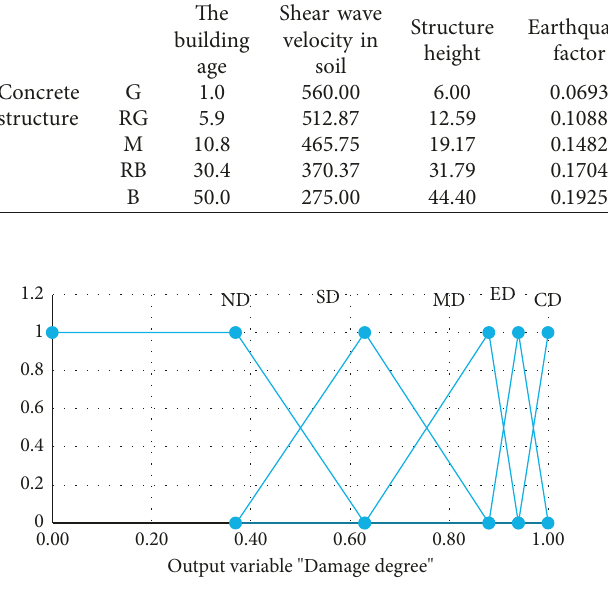
Figure 4: The membership function of the degree of damage to concrete